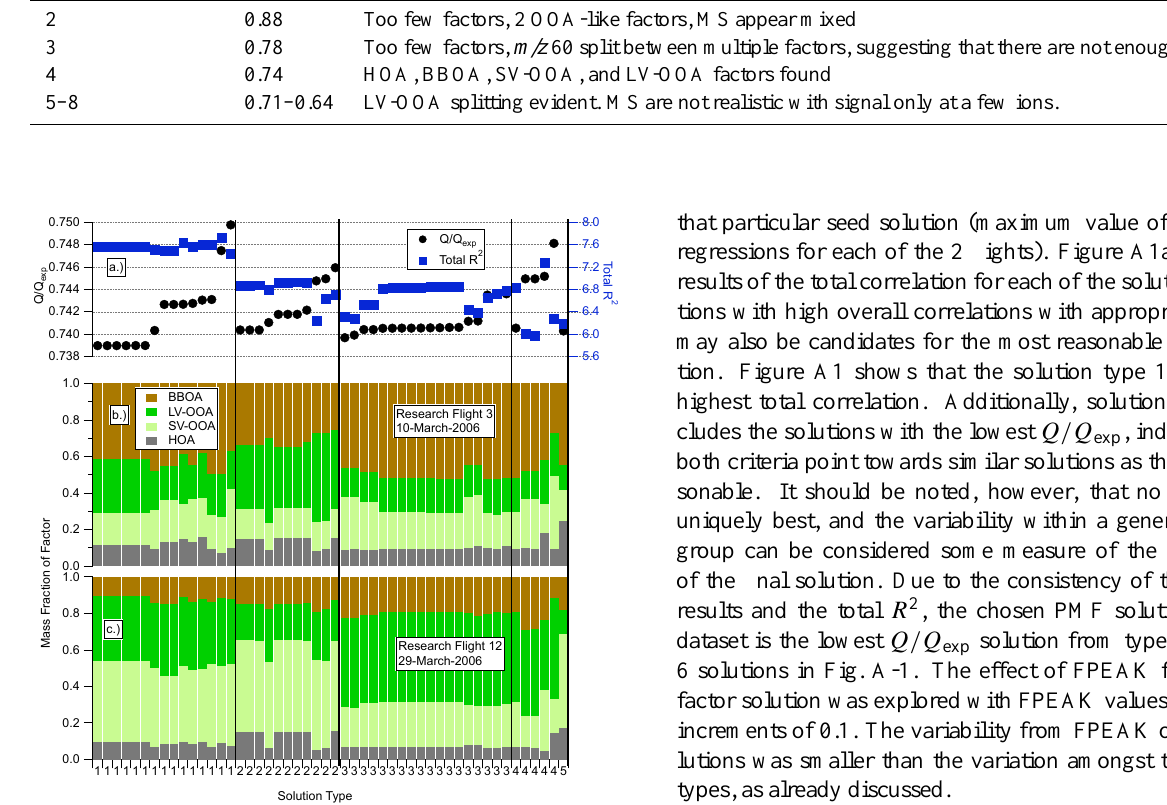
Fig. A1. (a) shows the Q/Q exp and total R 2 values for the 50 seed solutions organized by solution type. Each solution type is then sorted by increasing Q/Q exp . (b) and (c) show the mass fractions of the different factors for each of the 50 seed solutions, and the variability in the apportionment of the seed